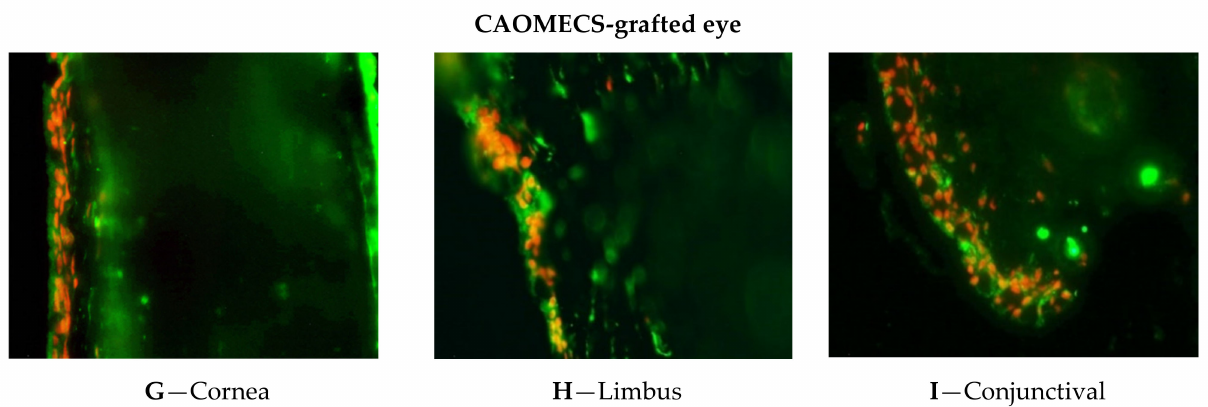
Figure 2. Immunofluorescent staining showing the expression pattern of ALDH1A3 in healthy ( A – C ), LSCD ( D – F ; 9 months after LSCD induction) and CAOMECES-grafted ( G – I ) New Zealand white rabbit corneas. ALDH1A1 expression is shown in green, and nuclei are shown in red. The included images are representations of many samples. Magnification is 40 ×